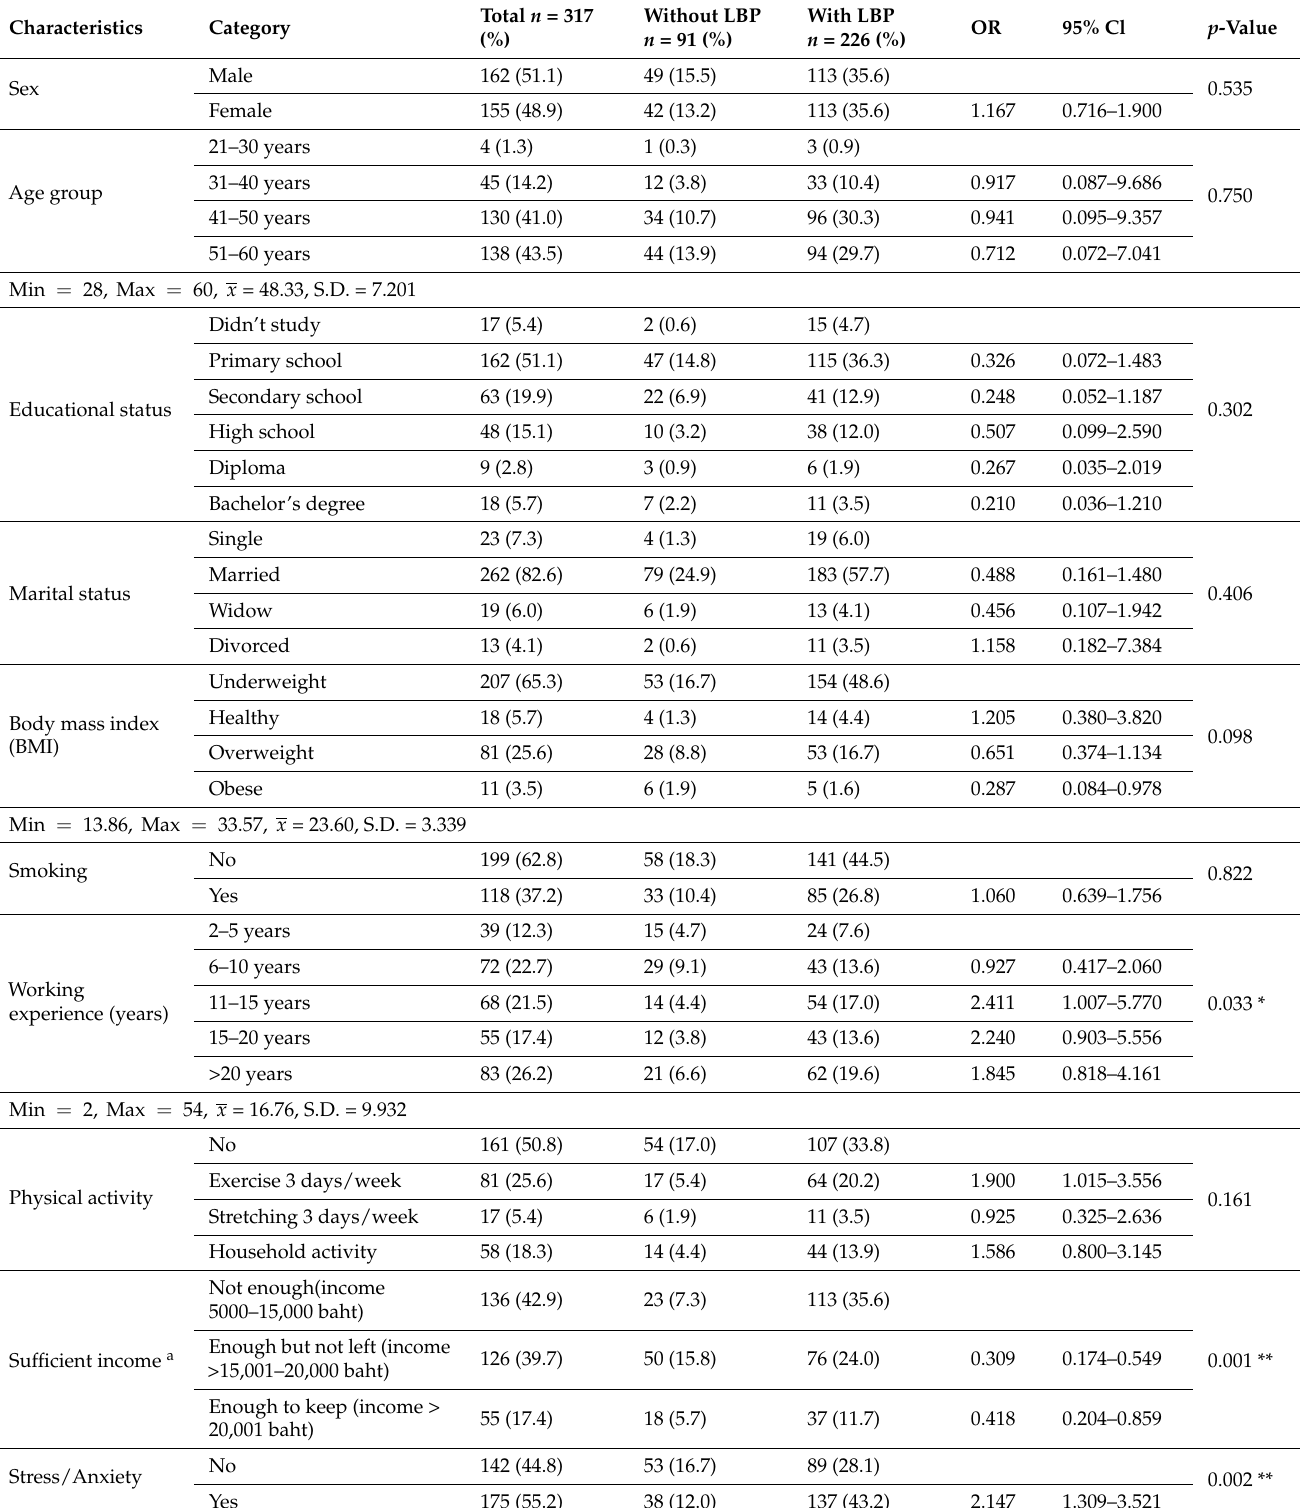
Table 1. Sociodemographic/individual characteristics of LBP predictors among rubber farmers ( n =